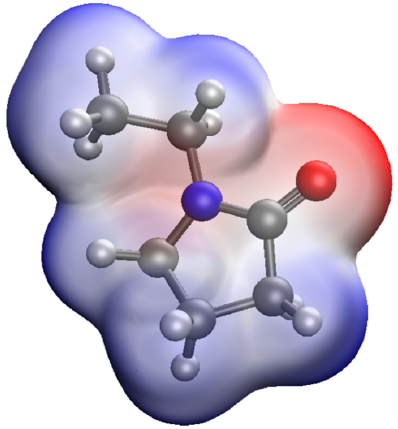
Figure 6. Model of PVP molecule with an electron density distribution.